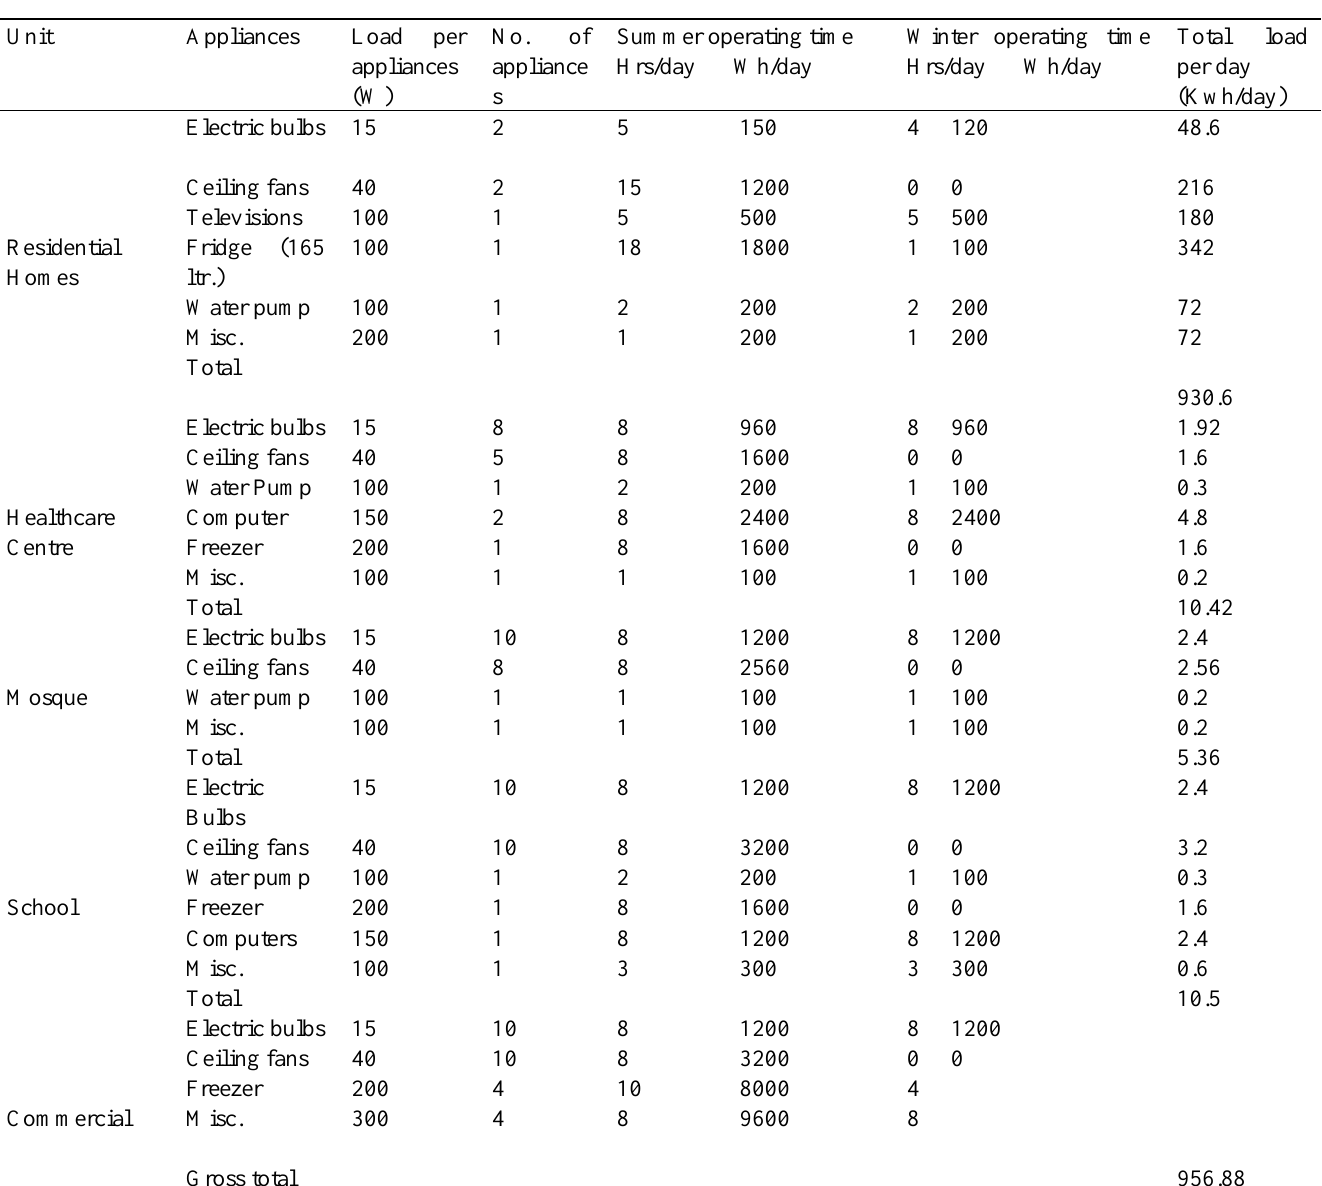
Estimated load of the